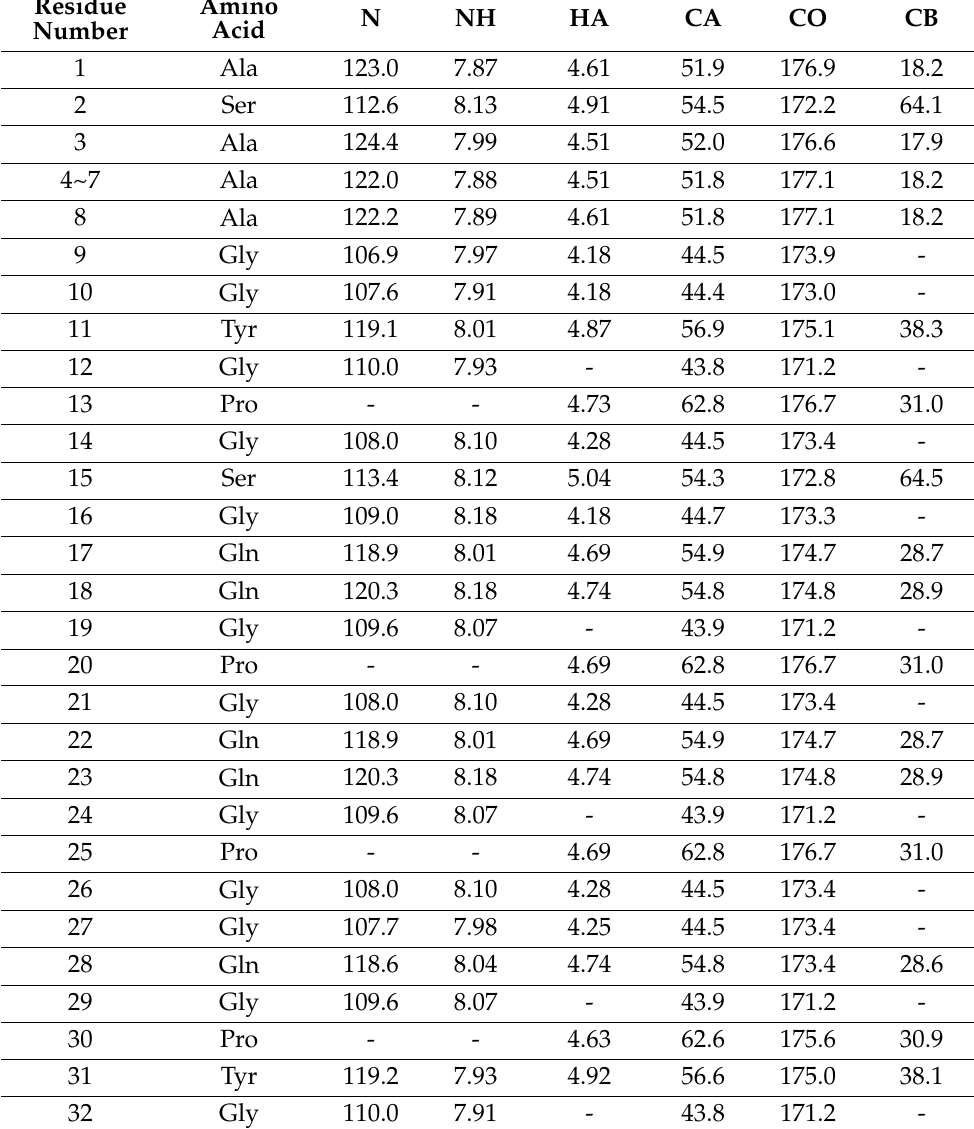
Table 1. 1 H, 13 C, and 15 N chemical shifts (in ppm) of amino acid residues in the 32-residue repetitive sequence of RSP in FA. Amino acids are described with three letter